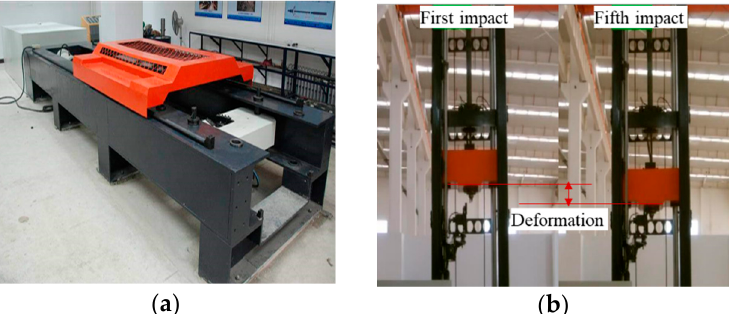
Figure 8. Laboratory test systems for CRLDA. ( a ) LEW-500 anchor cable tensile test system; ( b ) dynamic impact test system.